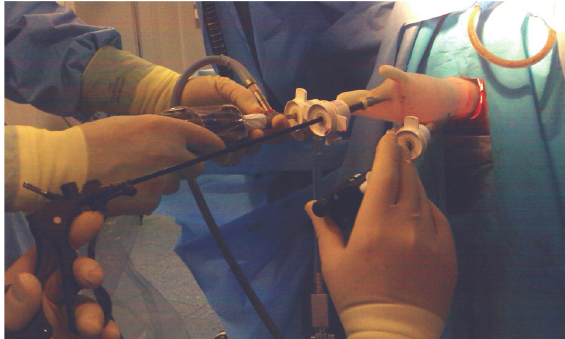
Figure 2: The laparoscopic camera is inserted via the middle finger port.